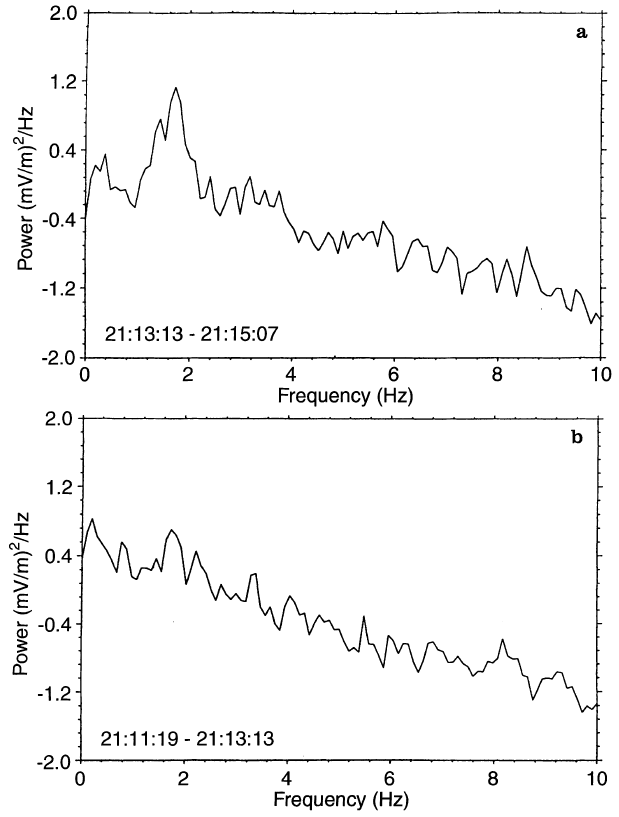
Fig. 10. Same as Fig. 3 for other time-intervals. The waves are very intense and the slopes of the spectra are very similar. At 21:11:19 UT the quasi-monochromatic wave is not clearly seen since the broadening of the emission spreads out below and above the